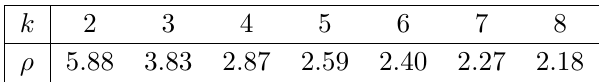
Table 18 . Values of the parameter ρ of the special complex marginal solution for different k